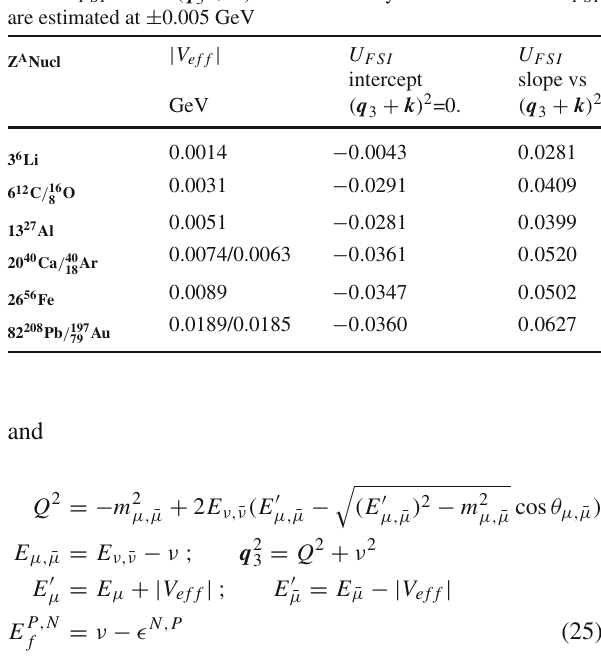
= 0 and slopes (GeV / GeV 2 ) of 3